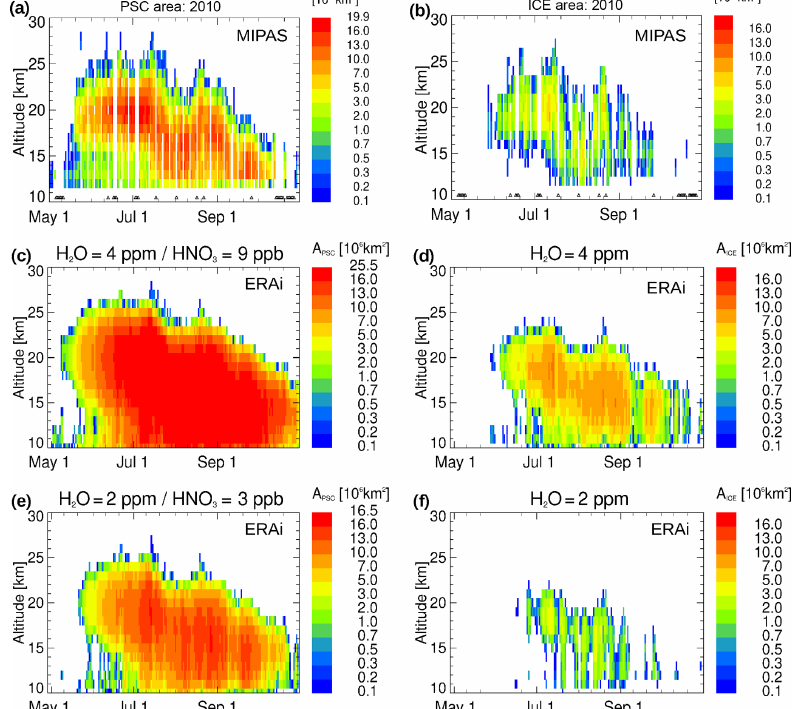
Figure 13. Time series of the daily Antarctic area of PSCs ( A PSC ) including all PSC classes and the area of the class ICE only ( A ICE ) for the year 2010 retrieved from MIPAS spectra ( a, b ; see also Fig. 11). This is compared with the standard calculation of PSC areas based on ERAi temperature data with constant stratospheric water vapour and HNO 3 values (c–f) . Results of two setups are presented for H 2 O of 4 and 2ppmv, respectively, in panels (c, d) and (e, f) , and for HNO 3 of 9 and 3ppbv, respectively, (c, e) to illustrate the usually observed effects of denitrification and dehydration in the polar vortex over the